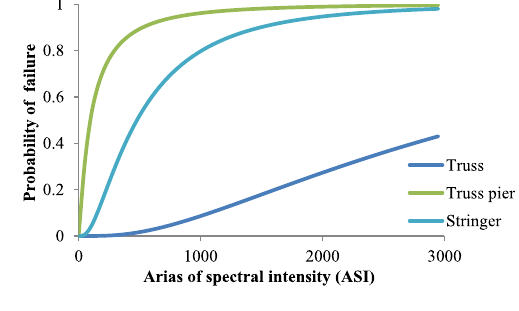
Figure 9. Component fragility.